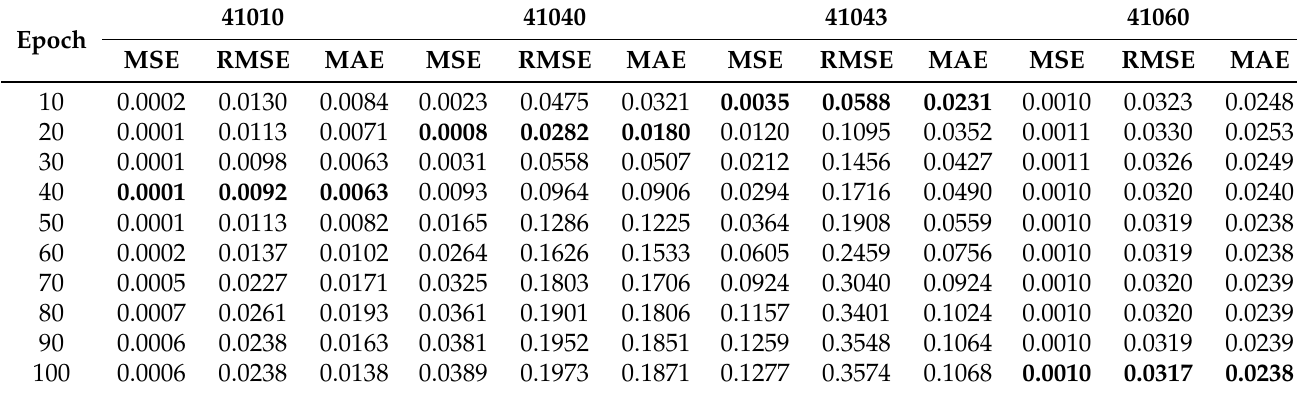
Table 7. Results of the proposed GRU-SCA model in all datasets.